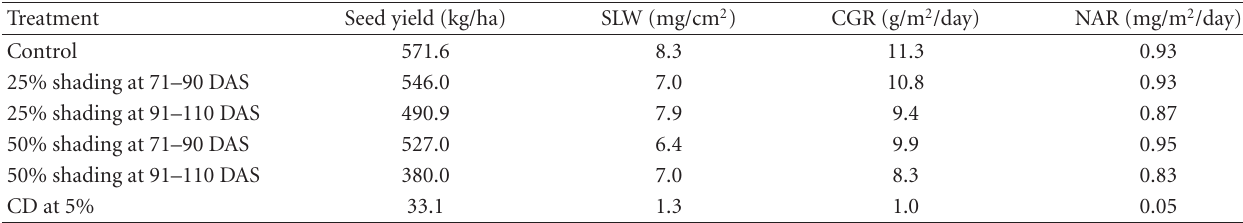
Table 5: E ff ect of shading on yield and growth parameters in Indian mustard at Hisar.